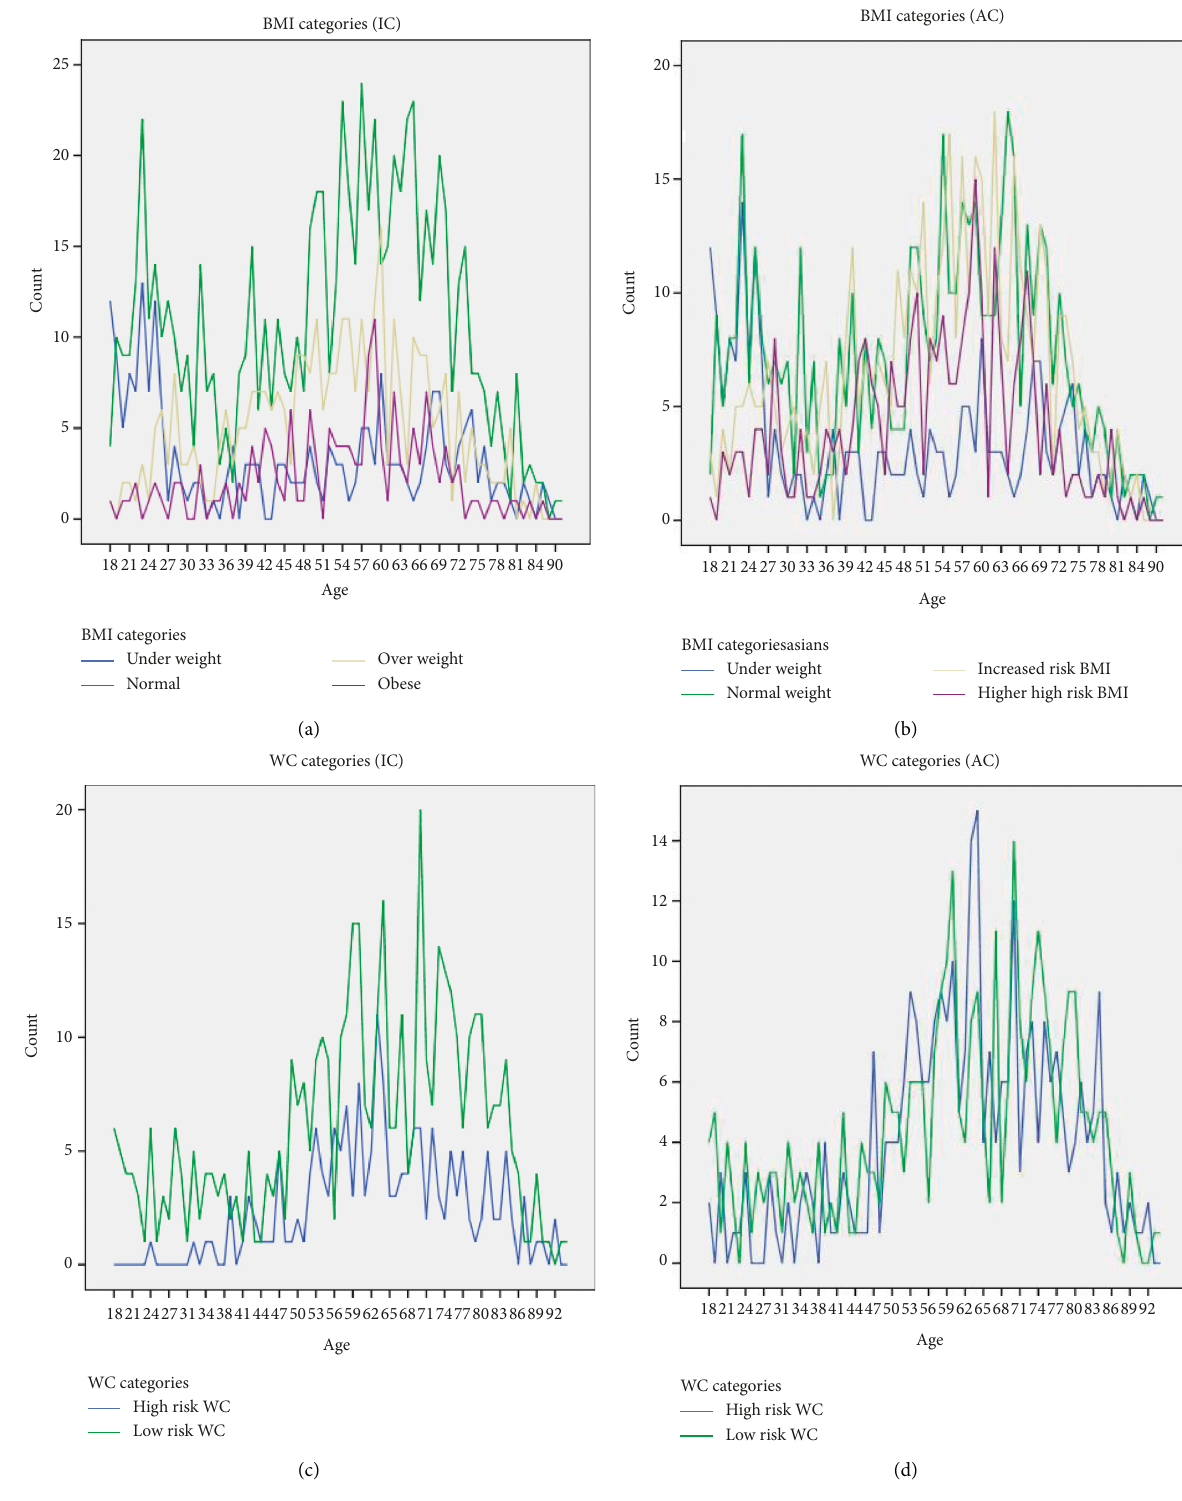
Figure 1: Distribution of BMI (kg/m 2 ) and WC (cm), according to age according to the international cut-offs and Asian cut-offs in (a), (b), (c), and (d),